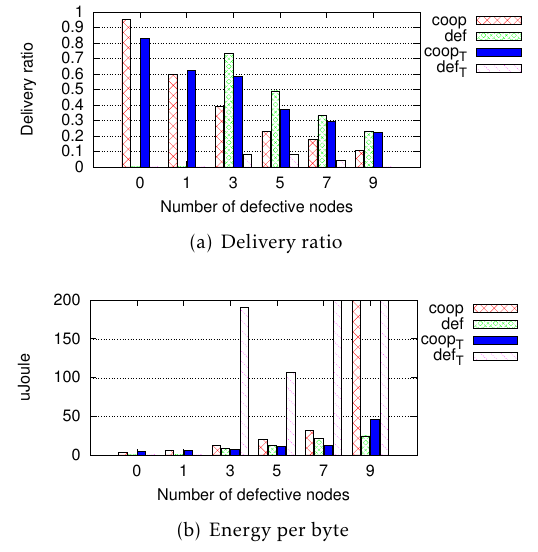
Figure 5. Fairing the delivery ratio